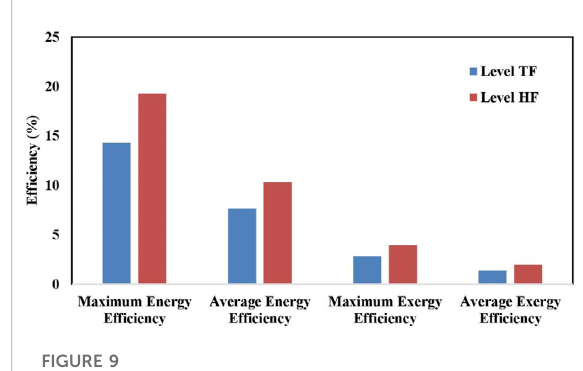
FIGURE 7 Hourly energy ef fi ciency variation with time.